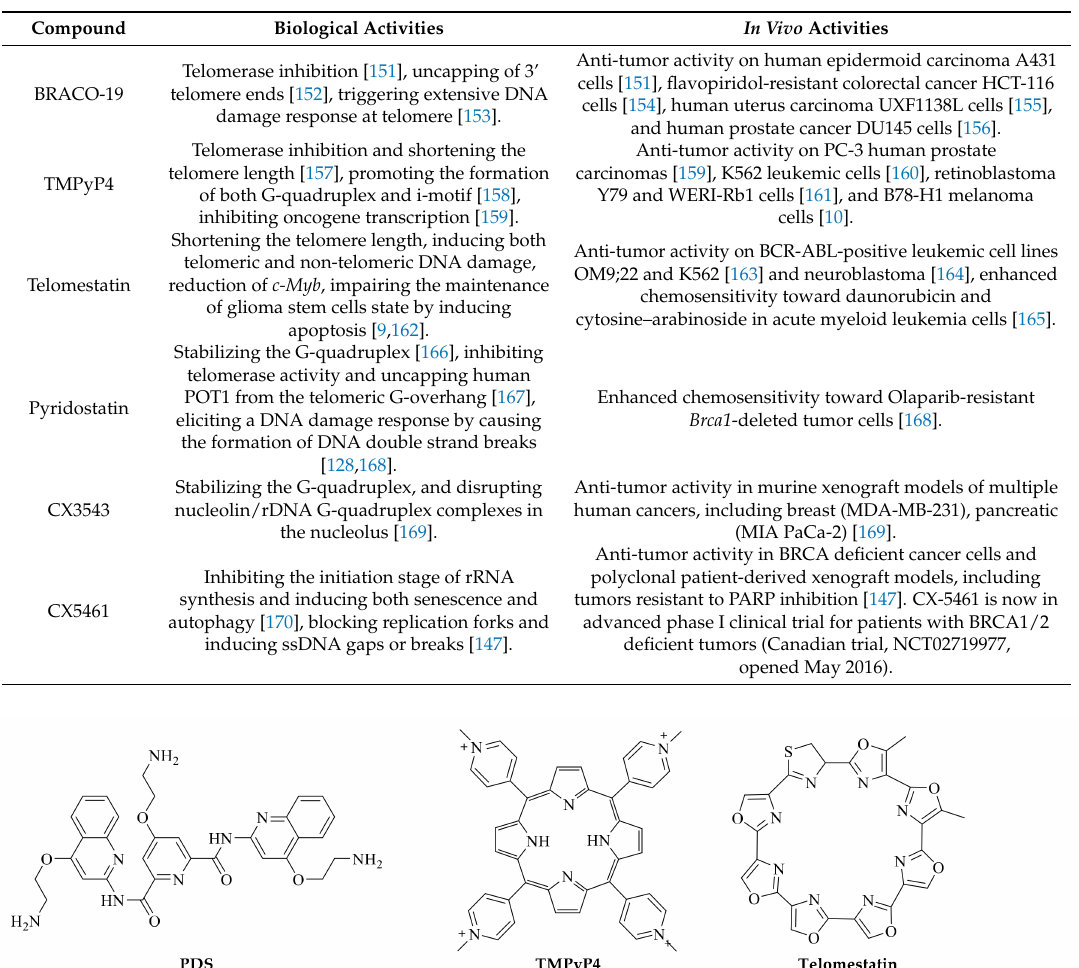
Table 1. Typical G-quadruplex ligands and their biological activities.